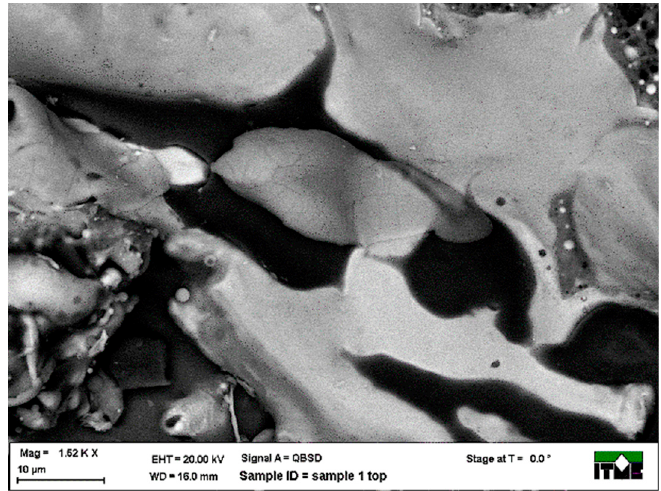
Figure 11. Example SEM image of the sprayed surface of the coatings.